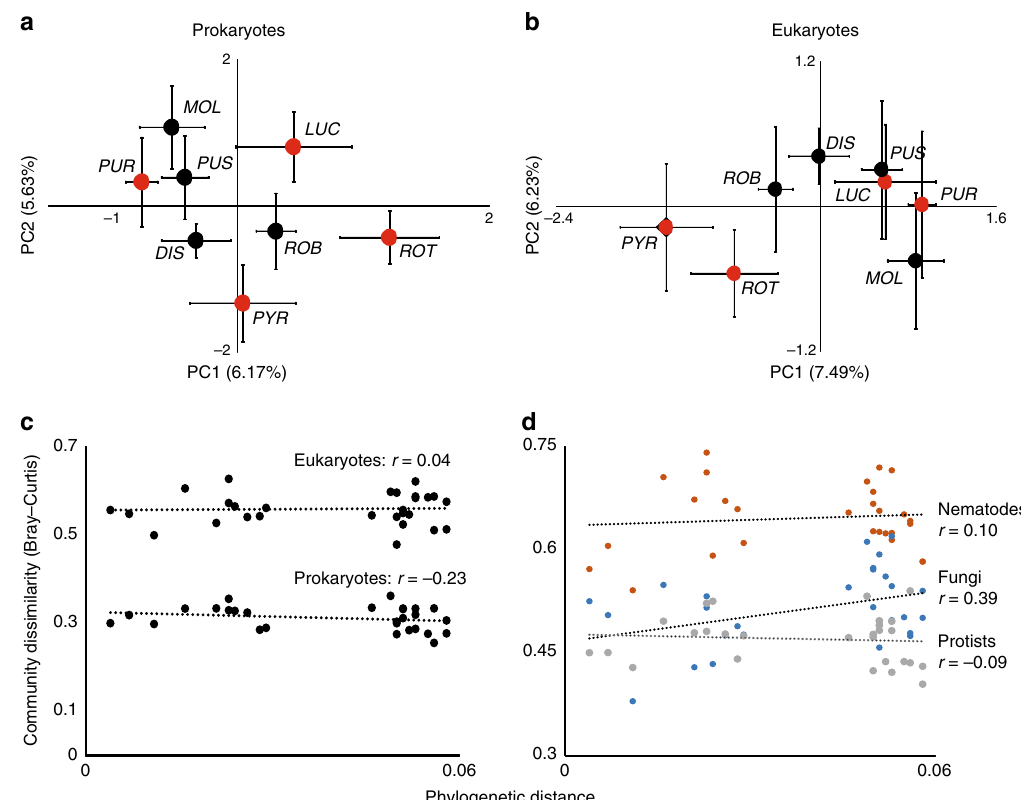
Fig. 1 Community composition of prokaryotes and eukaryotes. Compositional variation in rhizosphere communities of a prokaryotes (16S rRNA gene reads) and b eukaryotes (18S rRNA gene reads) among native (black dots: G. dissectum ( DIS ), G. molle ( MOL ), G. pusillum (PUS), and G. robertianum ( ROB )), and range-expanding plant species (red dots: G. lucidum ( LUC ), G. pyrenaicum ( PYR ), G. purpureum ( PUR ), and G. rotundifolium ( ROT )), based on fi ve independent replicate soils. Error bars represent SEs of PCA coordinates. Correlations of pairwise phylogenetic distance with community dissimilarity of prokaryotes and eukaryotes ( c ), and eukaryotic groups nematodes (orange), fungi (blue), and protists (gray) ( d ). The Pearson ’ s coef fi cient r for each correlation is shown